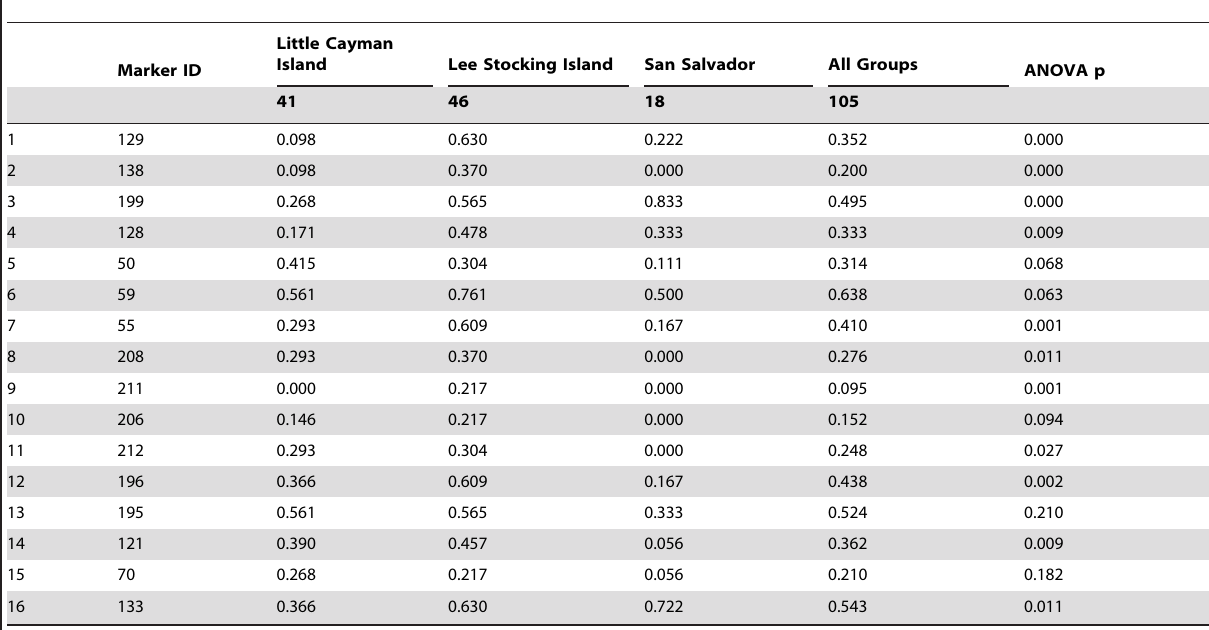
Table 7. Band frequencies for AFLP markers used in discriminant function analysis (DFA).